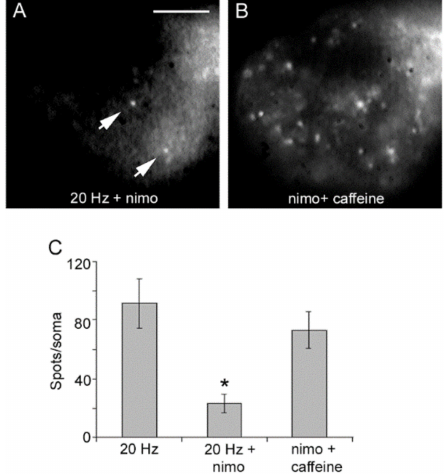
Figure 4. Activation of L-type calcium channels mediate somatic exocytosis. ( A ) Incubation with ni- modipine (nimo) abolishes evoked but not constitutive exocytosis upon 20 Hz stimulation. The spots pointed by the arrow remained in B. ( B ) Caffeine in the presence of nimodipine evokes vesicle trans- port and exocytosis in the absence of electrical stimulation. Images are selected areas of the soma. ( C ) Exocytosis quantified as the number of fluorescent FM1-43 spots per soma. Bars are the S.E.M.; the * indicates a p < 0.05 T test significance with respect to the 20 Hz and nimo+caffeine groups. The 20 Hz and nimo+caffeine groups were similar ( p > 0.05). Reproduced with permission from the publisher of